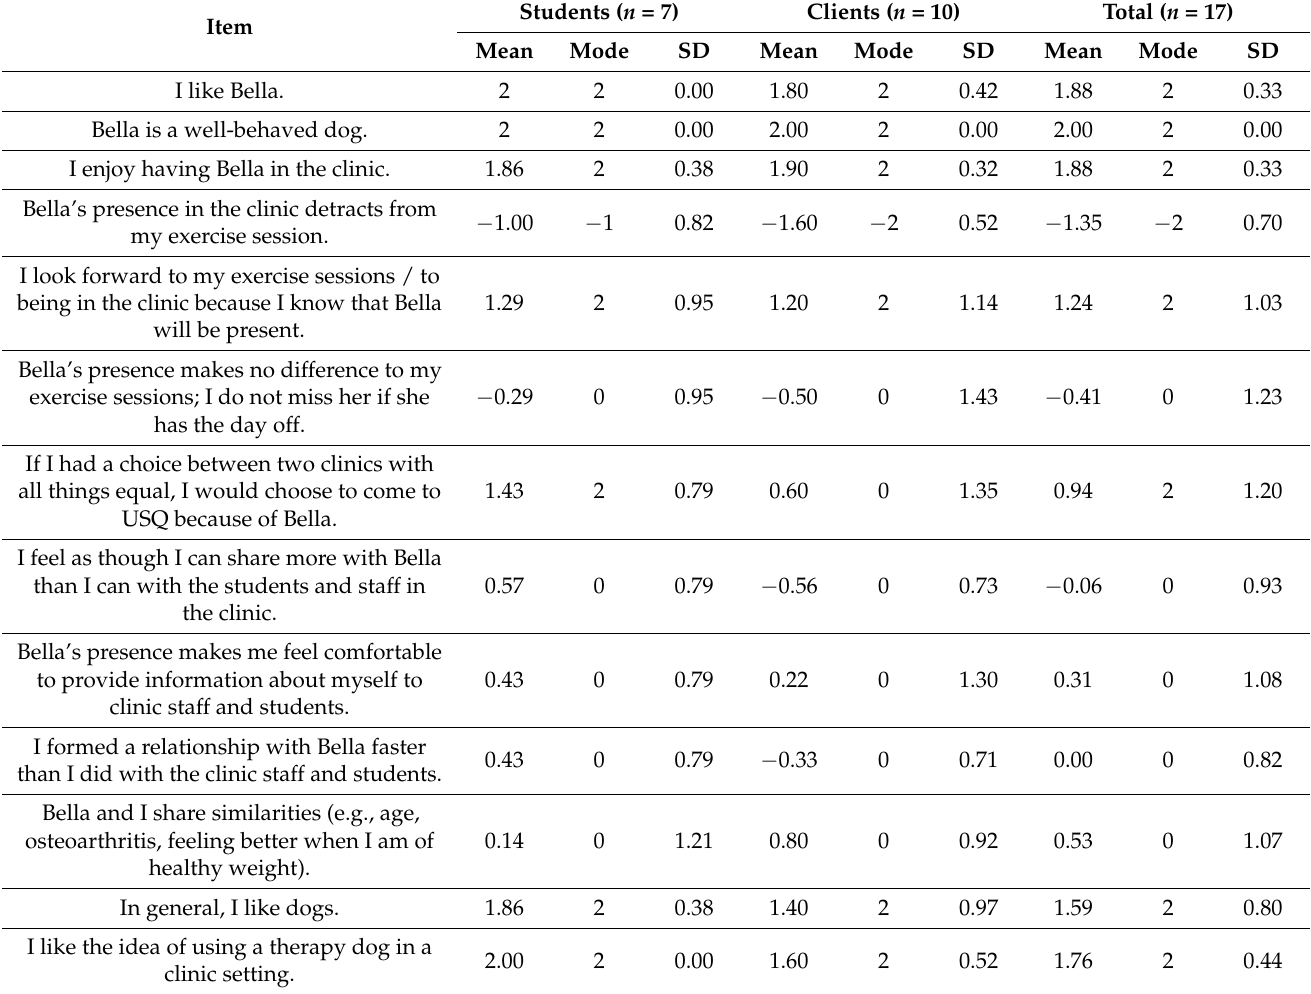
Table 1. Summary of responses to survey